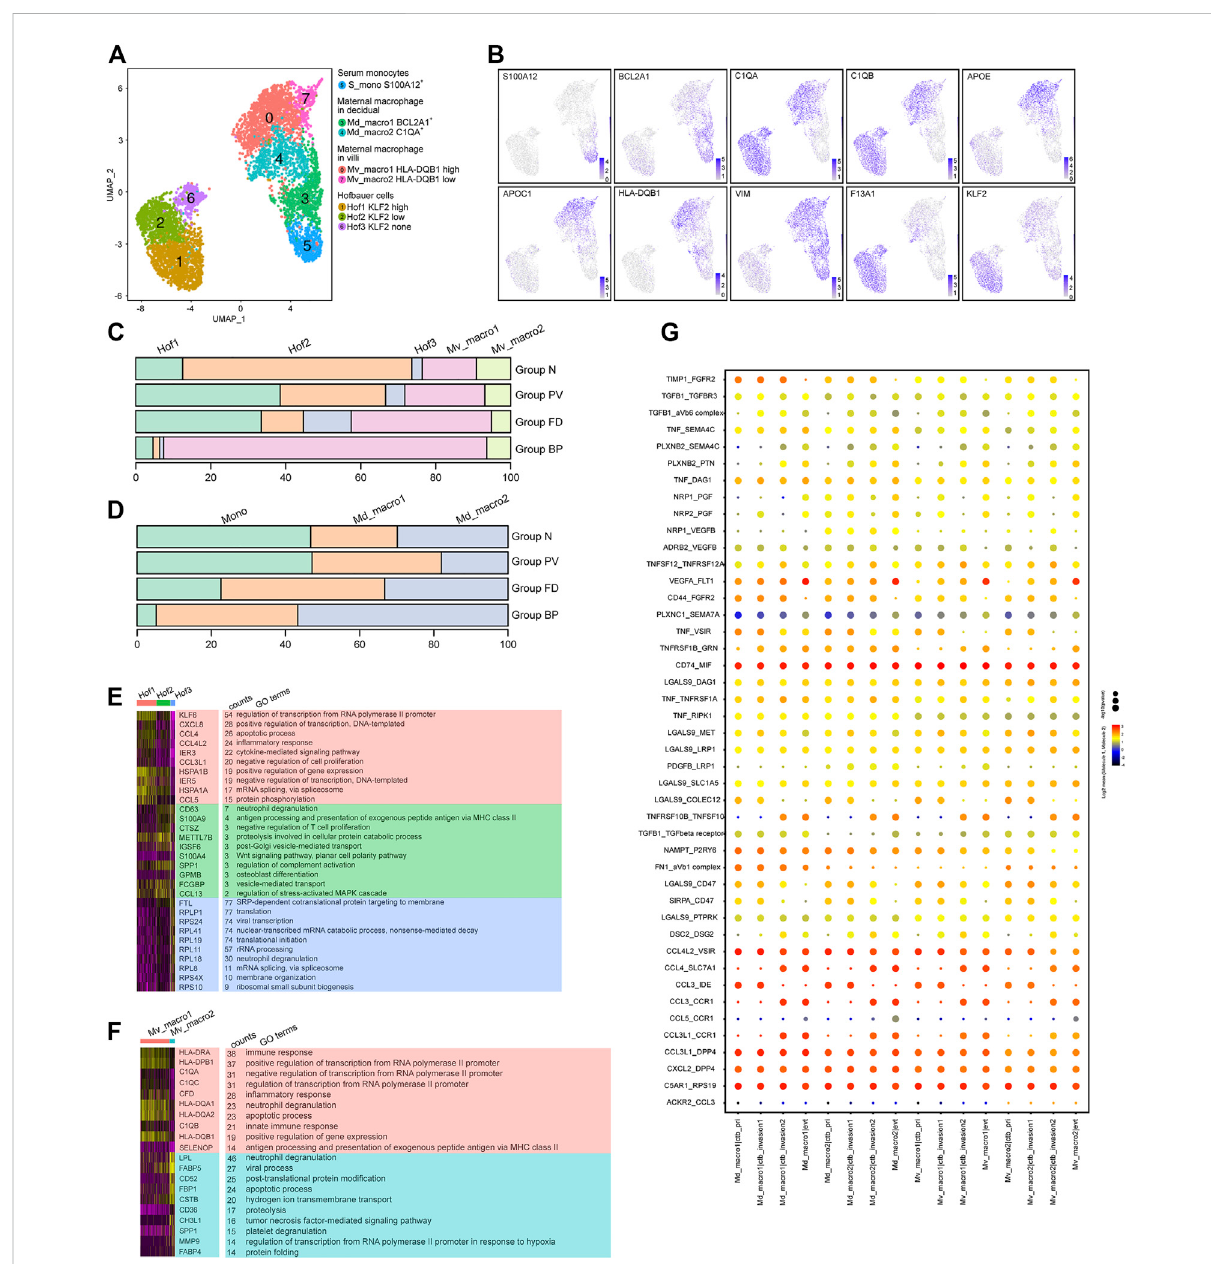
FIGURE 5 Multiple origins of macrophages at the maternal-fetal interface of the PAS were identi fi ed. (A) UMAP plot showing reclustering of macrophage cells ofhuman placenta withinvasive PAS. (B) UMAP featureplots showing representativemarkergenes for themacrophage clusters shown inPanel 5A, (C,D) . Stacked bar plots displaying the dynamics of cell types of fl oating villi (top panel) and basal plate (bottom panel) macrophage subtypes. (E) GO analysis for the indicated Hofbauer cell clusters and maternal macrophages in villi. (F) GO analysis for the indicated maternal basal